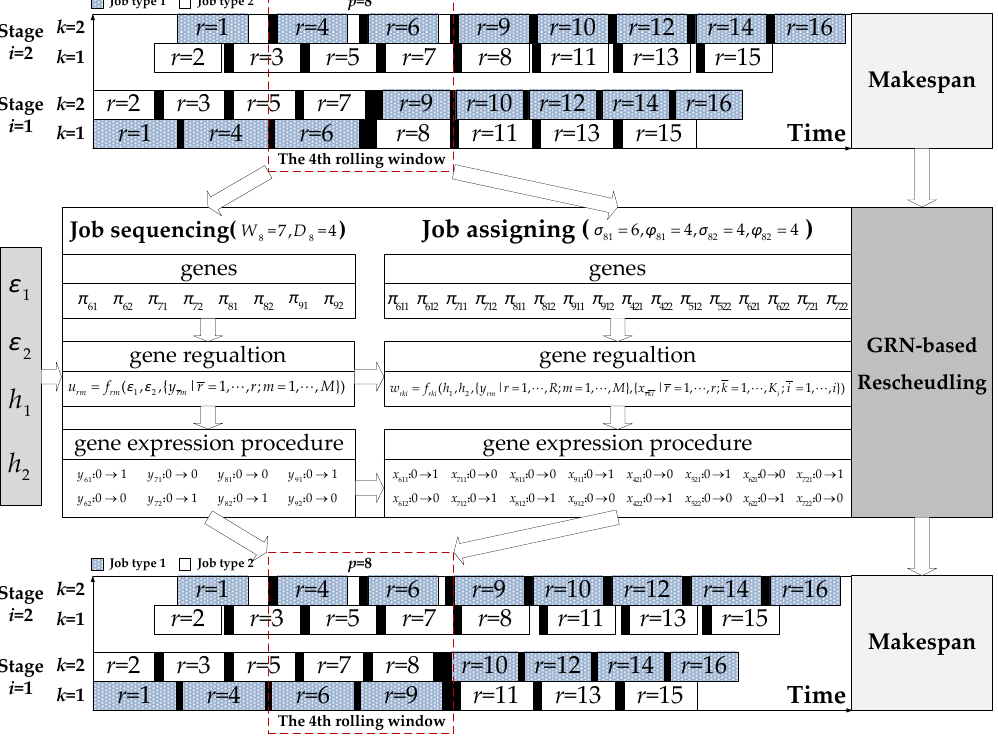
Table 2. Strategy parameter analysis experiment.